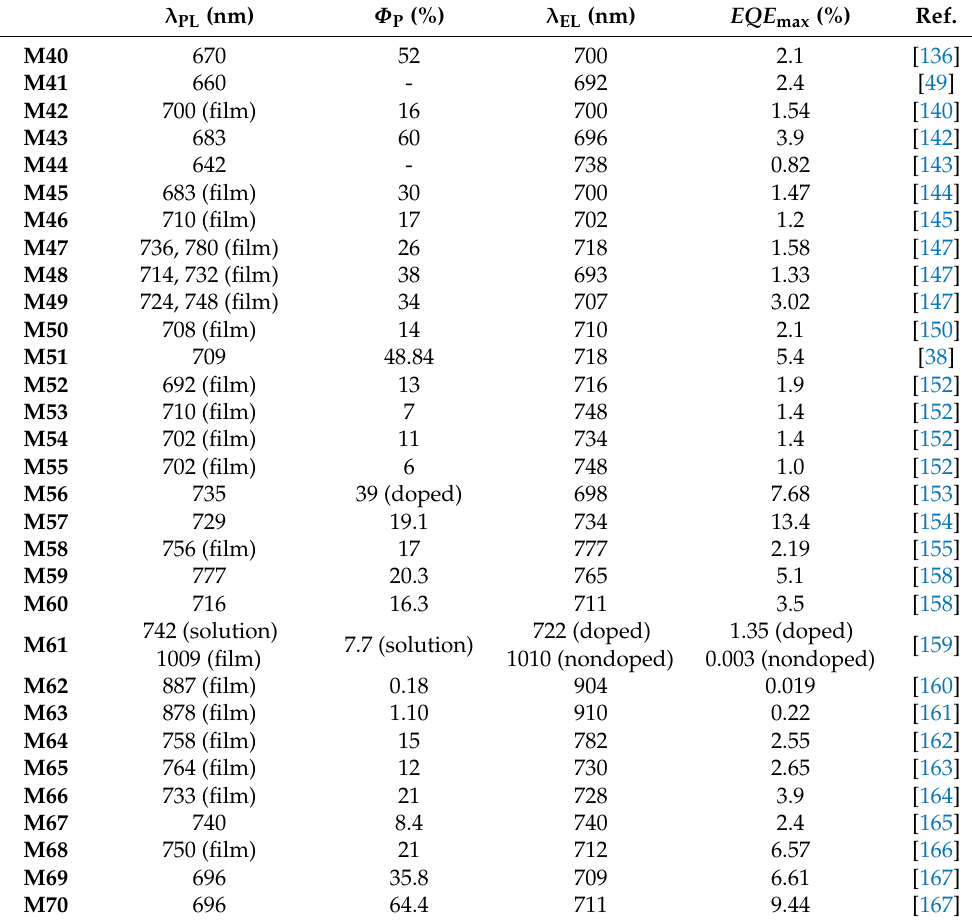
Table 3. Photophysical and electroluminescent properties of some NIR phosphorescent organic molecules.